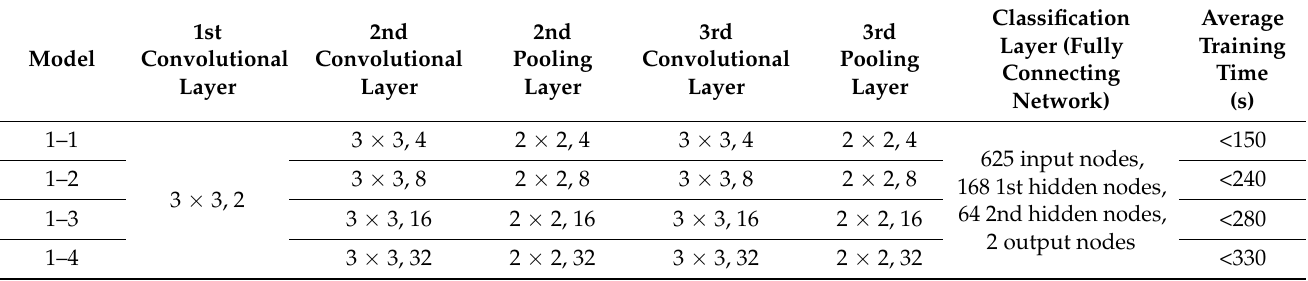
Table 9. Comparisons of the training CPU time for multilayer CNN-based classifiers with different numbers of Kernel convolutional windows and maximum pooling windows in second and third convolutional-pooling layers.